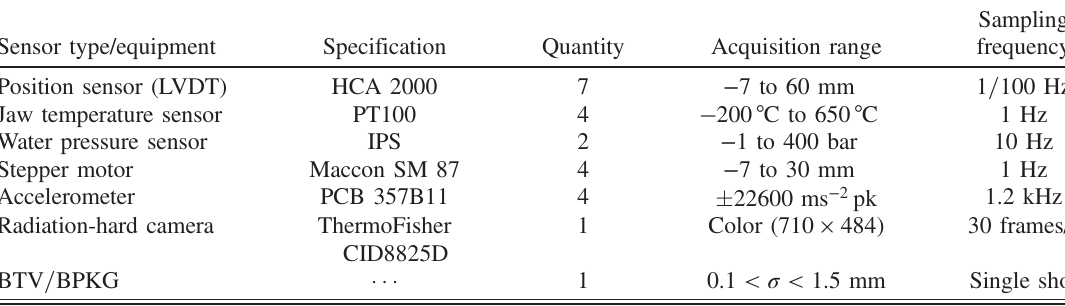
TABLE II. Main characteristics of the instrumentation used in the